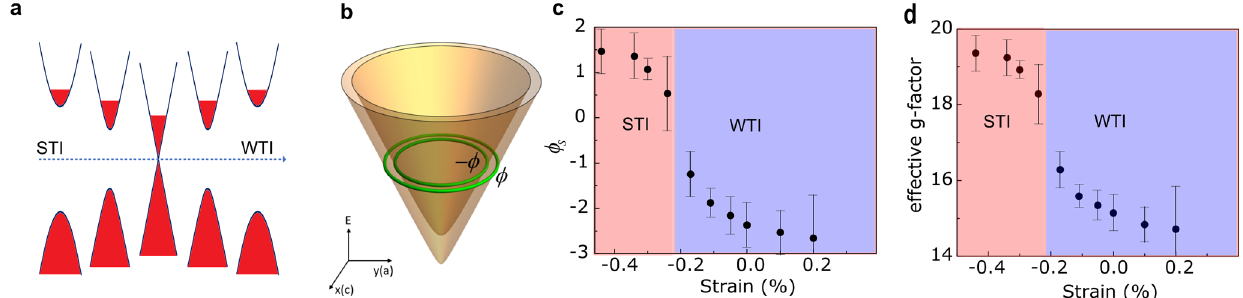
Fig. 4 Evolution of band structure and Zeeman effect over strain. a Evolution of Dirac band and Fermi level through the STI to WTI phase transition with increasingly tensile strain. b Schematic energy dispersion with k z = 0 and magnetic fi eld in the z(b) direction. Green circles indicate the boundary of extremal cross-sections for the spin bands. The spin-dependent Berry phases are ϕ and − ϕ over the two circles. c spin-dependent Berry phase ϕ s as a function of strain, calculated with mass gap and Fermi energy obtained from the SdH oscillations. d Strain tuning of effective g-factor. In both ( c and d ), the vertical error bars are determined through standard error importance of spin-dependent Berry phase in the Zeeman illustrated in Fig. 3f with the band parameters tuned along the effect. We also note that in our theoretical model, the value of trajectory in the ( Δ , μ ) parameter space shown in Fig. 3e. By R S is dependent on both the amplitude and the sign of the contrast, the conventional modeling of Zeeman effect on SdH energy gap Δ . The quantitative comparison between the oscillations which only considers the Fermi surface splitting theoretical model and our data on R S , as shown in Fig. 3e (Eq. (5)) completely fails to match with the experimental observations. This comparison de fi nitively highlights the and f, therefore reveals a sign-change in band gap near where its